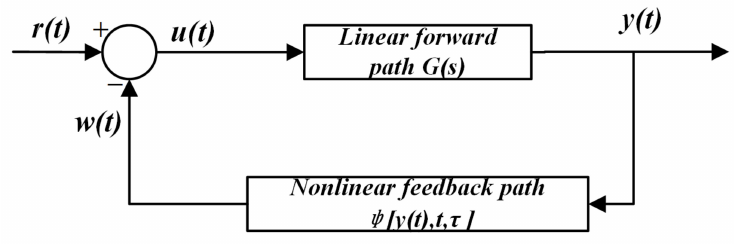
Figure 5. Block diagram of the structure of a non-linear feedback